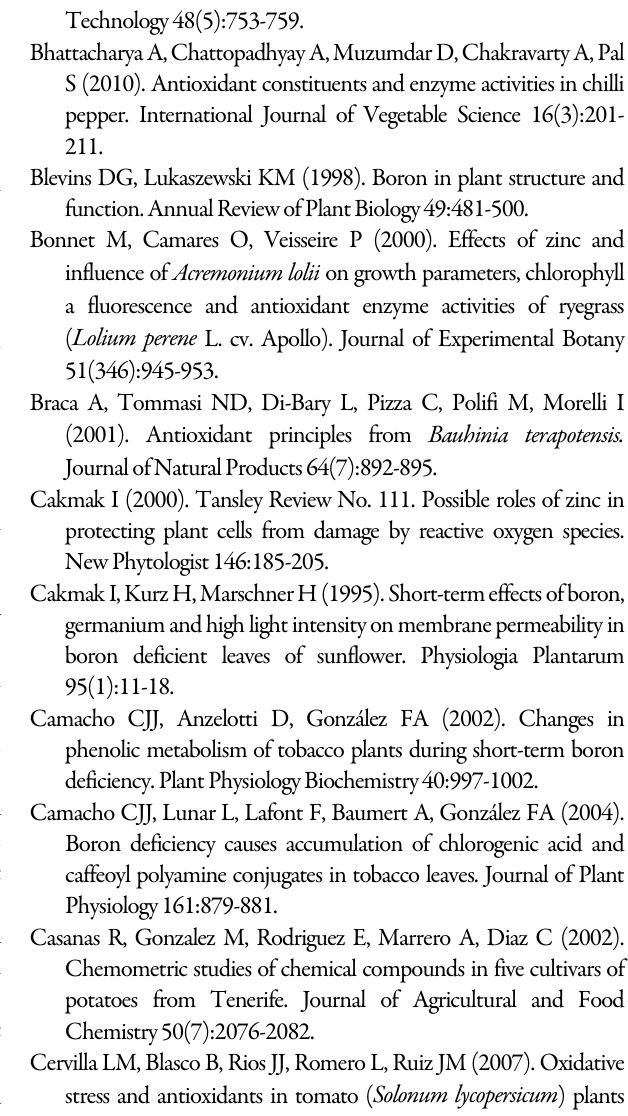
Fig. 2. Scatter diagram of the regression factor scores for the first and third components produced by